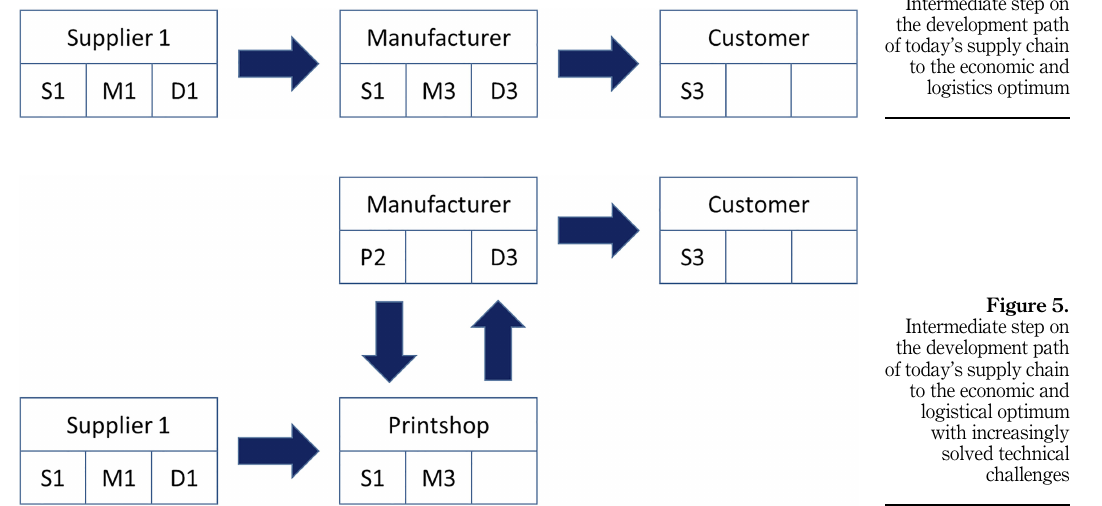
Figure 5. Intermediate step